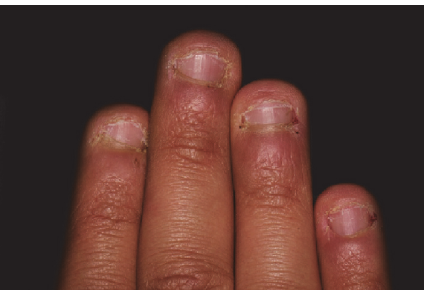
Figure 3: Patient simulating the occlusal position of nail biting. Note the coinciding outlines of the incisal notch and the antagonist incisal-edge surfaces.